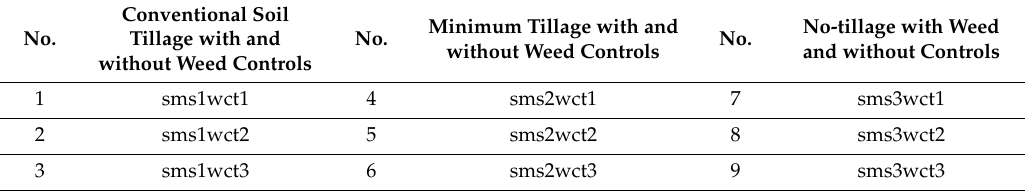
Table A1. The layout of soil tillage systems with weed controls.